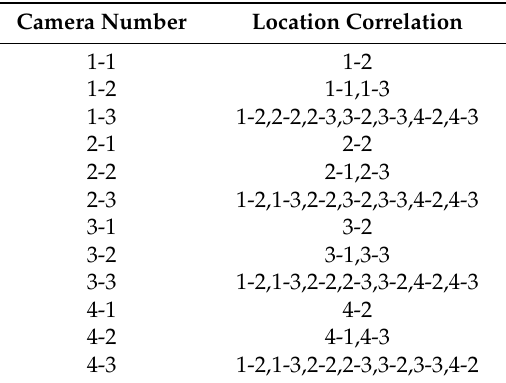
Table 5. Camera correlation